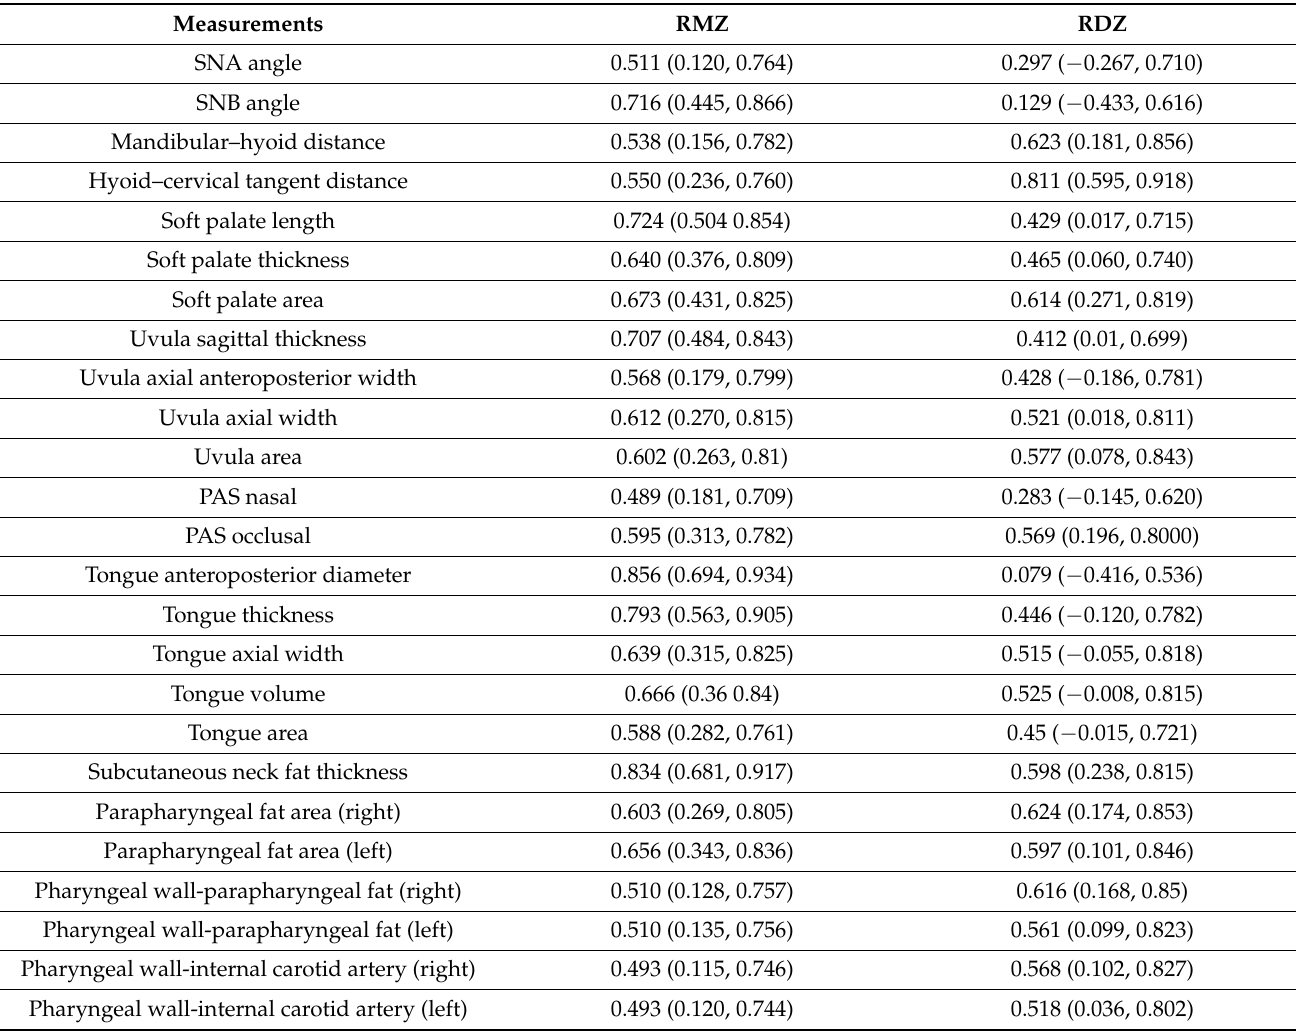
Table 3. Intraclass correlations of MZ and DZ groups RMZ: MZ correlation, RDZ: DZ